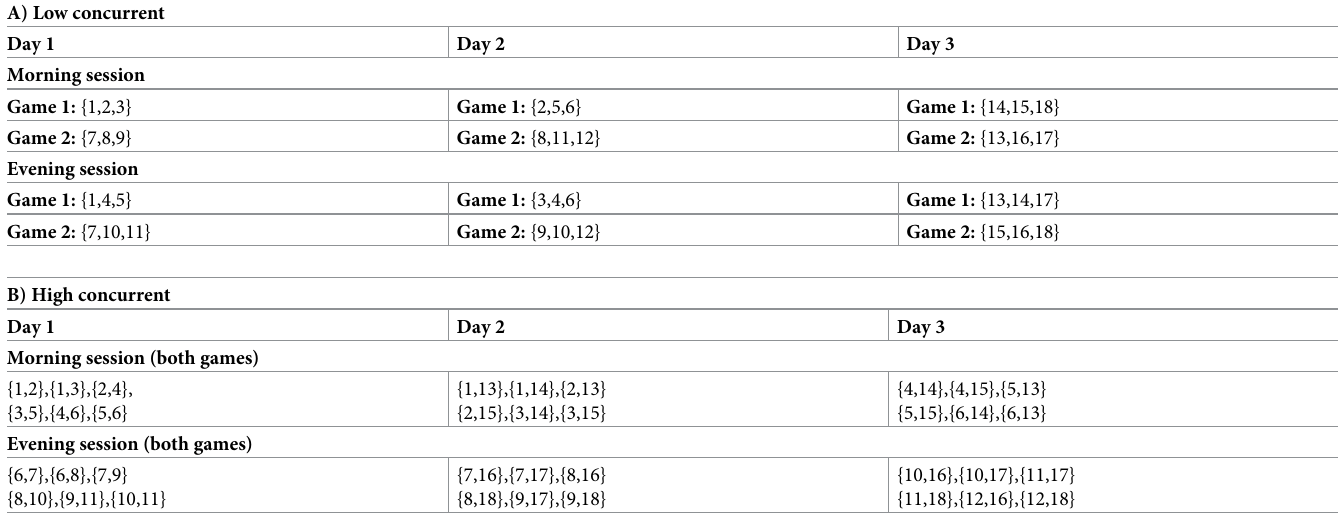
Table 2. Example arrangement of images across days in conditions of high cumulative diversity. Each number corresponds to an image subjects learned about. The arrangement ensured that every image would be pitted against four distinct images across two learning sessions Brackets group images that were pitted against each other. A) Low concurrent. Each game consisted of three images each pitted against the two other images. B) High concurrent. Each game consisted of six images, with each image pitted against two other